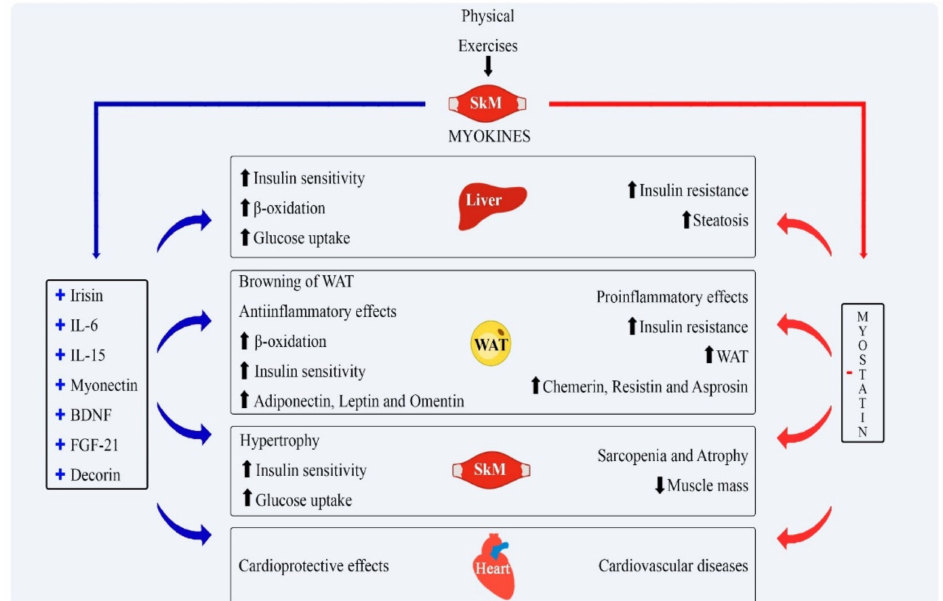
Figure 2. General actions of the main myokines in the metabolism. Physical exercise is the stimulus for the release of most myokines, while it inhibits myostatin release. The actions of these myokines are outlined as shown in the figure above. + represents activation; − represents inhibition; blue arrows reflect the actions of myokines stimulated by exercise; red arrows reflect the actions of myostatin; black arrows represent stimulation of physical exercises on skeletal muscle and the release of myokines. IL-6: interleukin-6; IL-15: interleukin-15; BDNF: brain-derived neurotrophic factor; FGF-21: fibroblast growth factor-21; SkM: Skeletal Muscle; WAT: White adipose